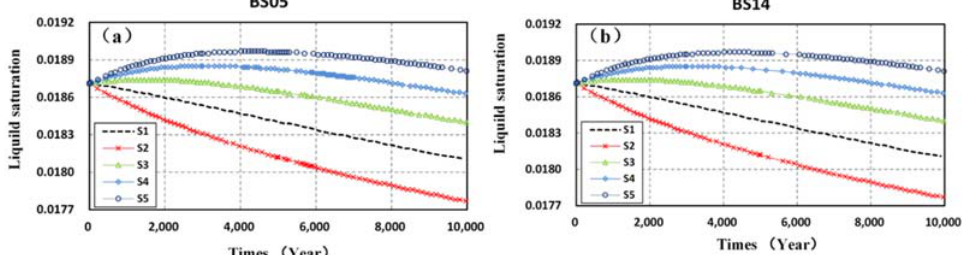
Figure 12. Change of liquid saturation under different precipitation conditions with time: ( a ) for the